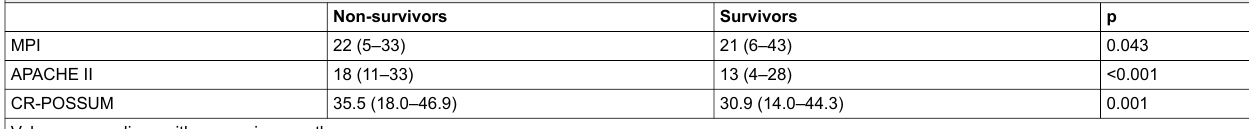
Table 4: Non-survivors showed significantly higher MPI, APACHE II, and CR-POSSUM scores than survivors.